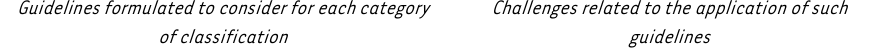
TABLE 1: Concluding summary Guidelines formulated to consider for each category of classification